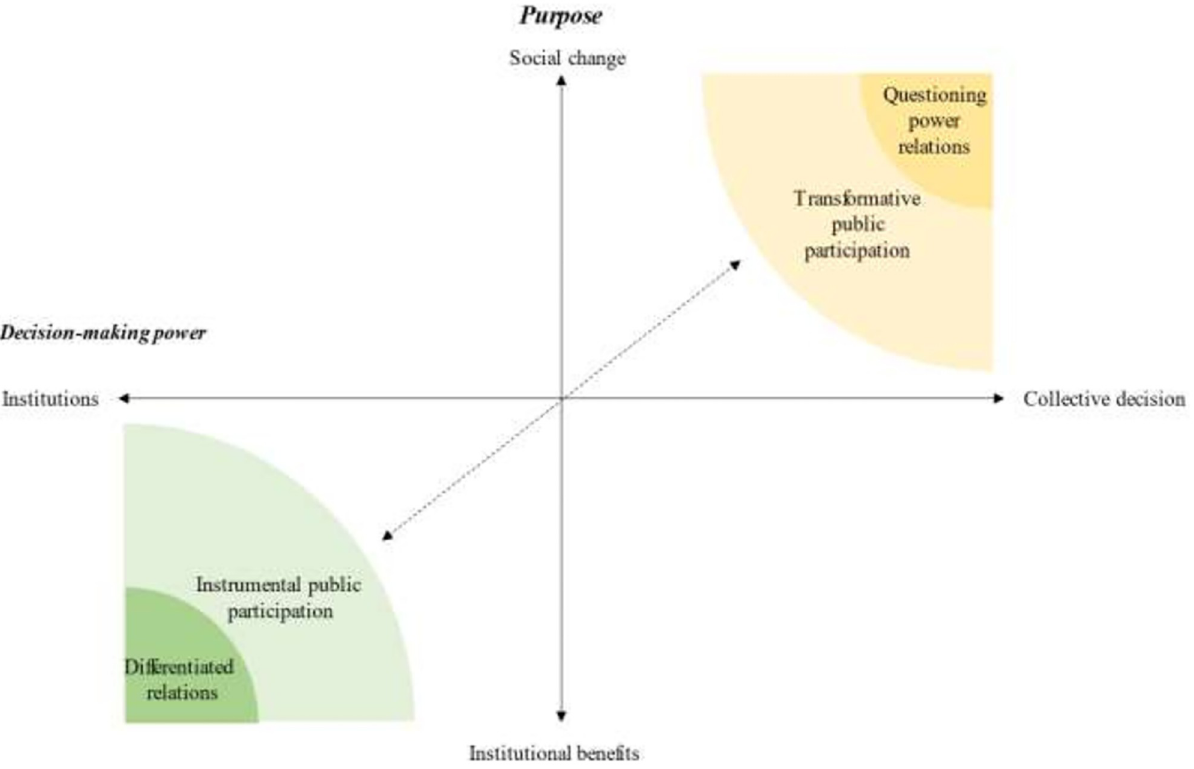
Fig 1. Discursive positions on PR according to a critical discourse analysis of people with experience in participatory processes (21 individuals).